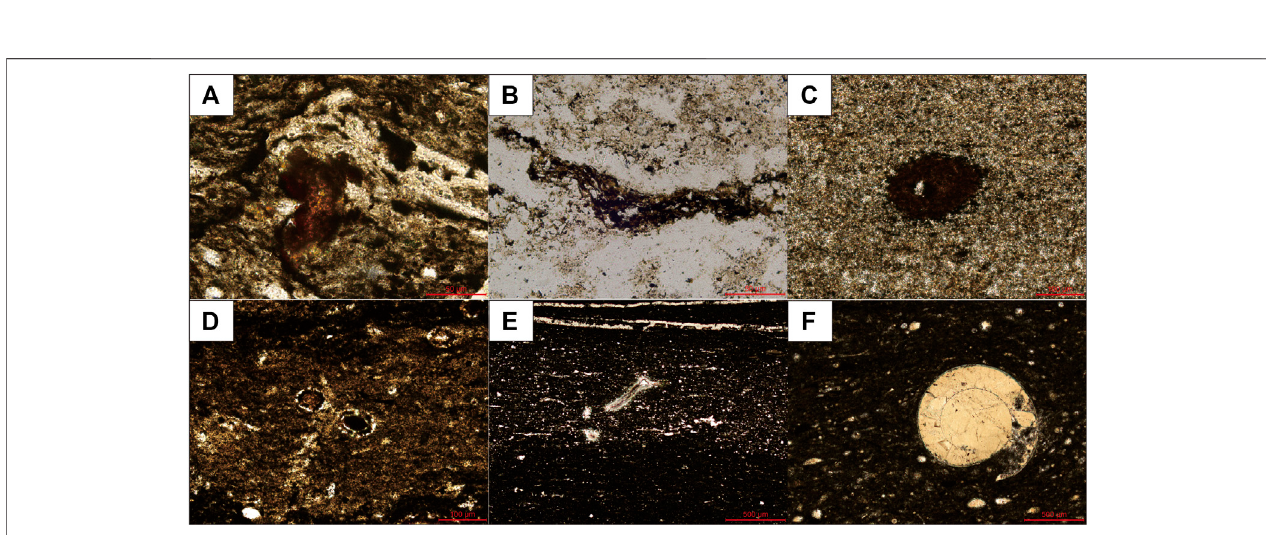
FIGURE 7 | Biological fossils of Dalong Formation in Longfeng quarry section. (A) Planktonic algae; (B) benthic algae; (C) acritarchs; (D) radiolaria; (E) sponge spicule; and (F) foraminifera.